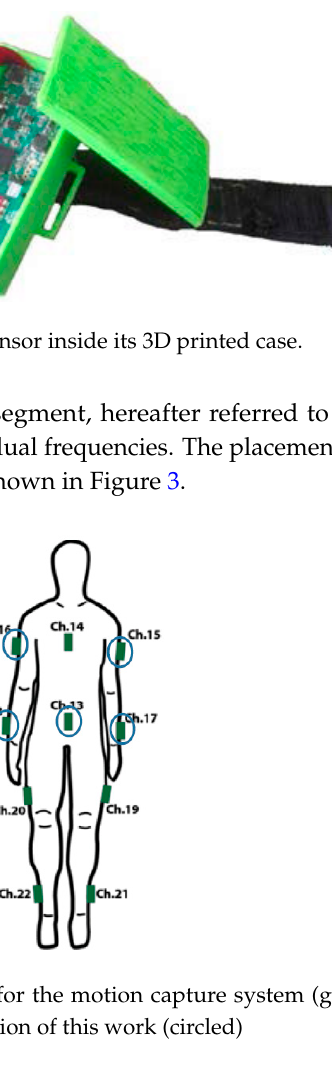
Figure 4. ( a ) Global orientation of sensor on startup; ( b ) Global reference frame of the sensor on the right upper arm; ( c ) Character’s arm orientation in Unity's axis frame.